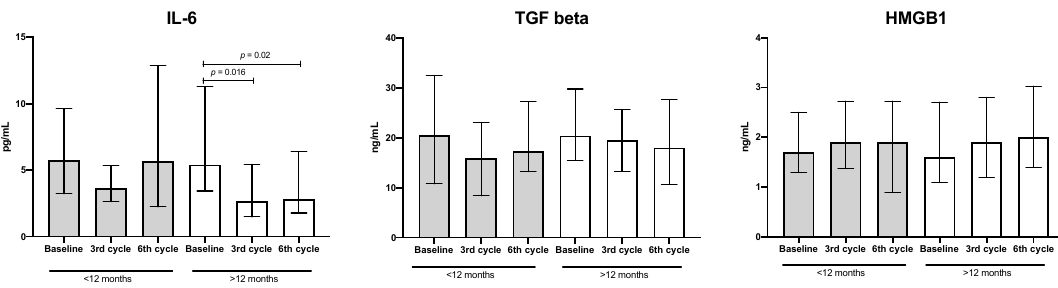
Figure 3. Concentration of IL-6, TGF- β , and HMGB-1 in patients with shorter (<12 months, n = 22) or longer (>12 months, n = 31) OS. Median and interquartile ranges are shown.